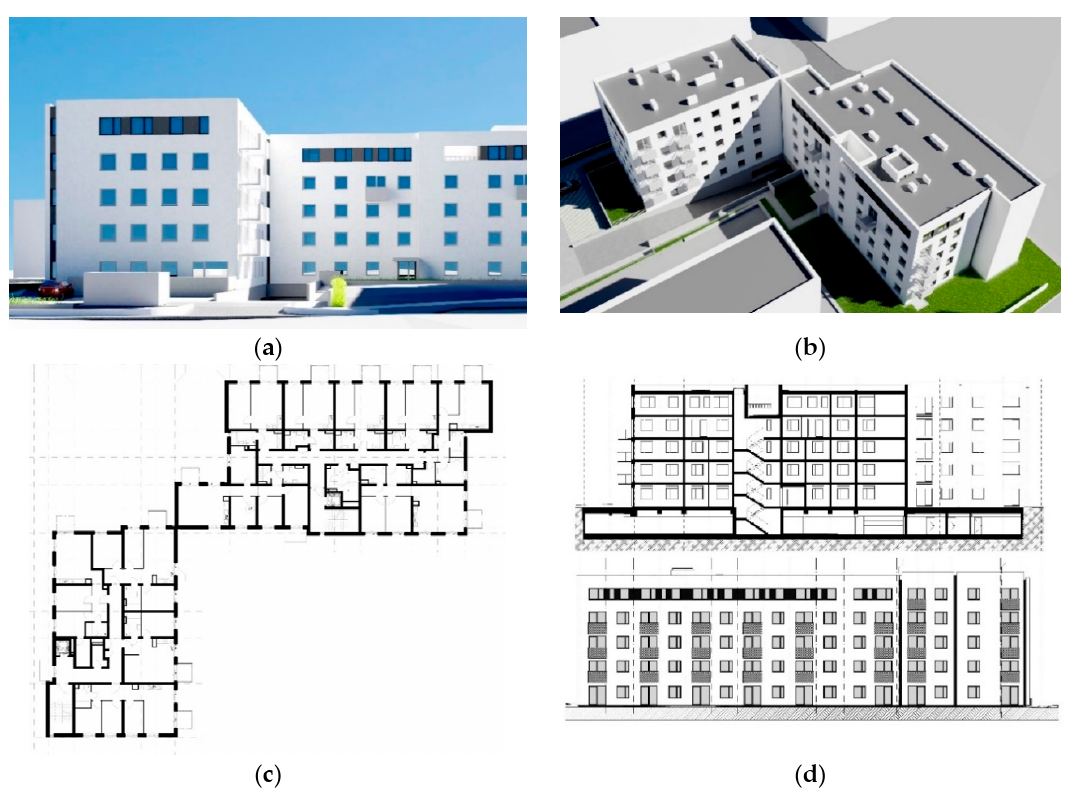
Figure 3. The building at Akacjowa Street in Goleniow. ( a ) Visualization 01; ( b ) visualization 02; ( c ) floor plan; ( d ) cross section and east elevation.